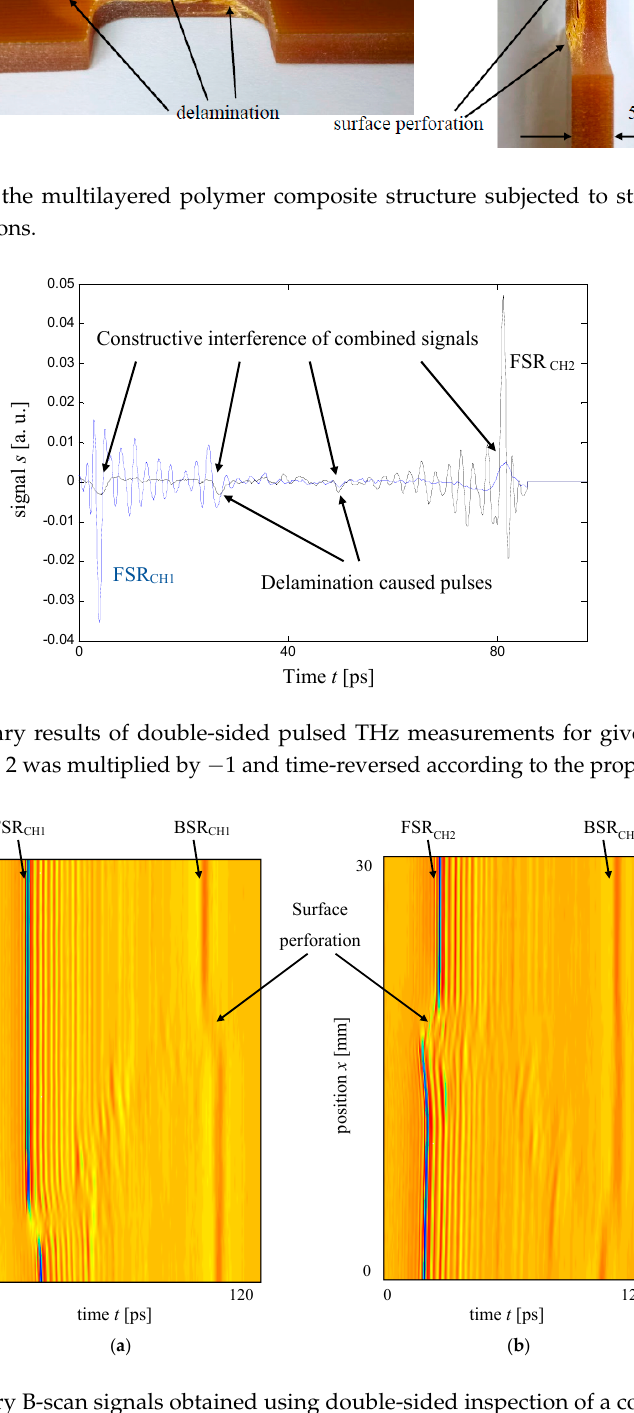
Figure 12. B-scan signals prepared for weighted summing: ( a ) deconvolved channel 1 signal g mCH1 ( t , x ); and ( b ) time reversed channel 2 signal g mCH2 ( − t , x ).